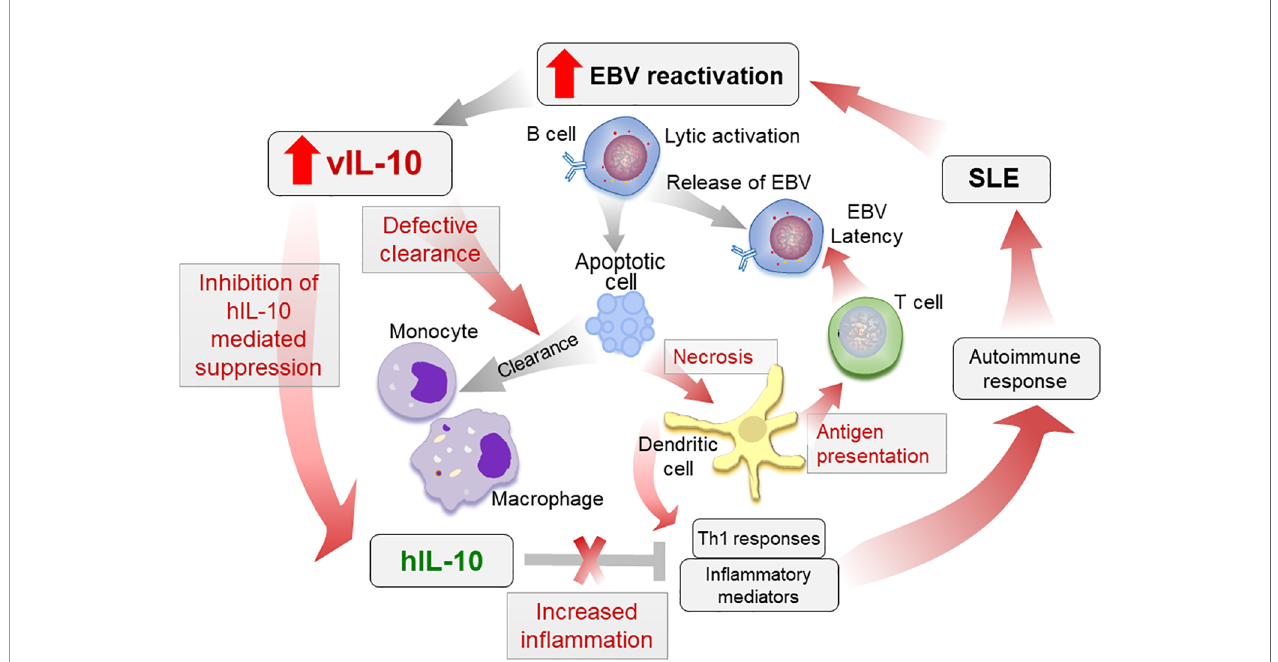
FIGURE 2 | Proposed role of vIL-10 in SLE pathogenesis. Increased reactivation of EBV in SLE patients increases vIL-10. vIL-10 competes with hIL-10 for IL10R1 and inhibits the suppressive effects of hIL-10 on myeloid cells. vIL-10 also reduces the ability of monocytes/macrophages to clear apoptotic cells. This leads to increased secondary necrosis, increased presentation of antigens by dendritic cells (DCs), and allows virus to establish latency. Reduced clearance of apoptotic cells leading to secondary necrosis along with increased antigen presentation and in fl ammatory responses exacerbate autoimmune response in SLE. The processes possibly regulated by vIL-10 are shown in red